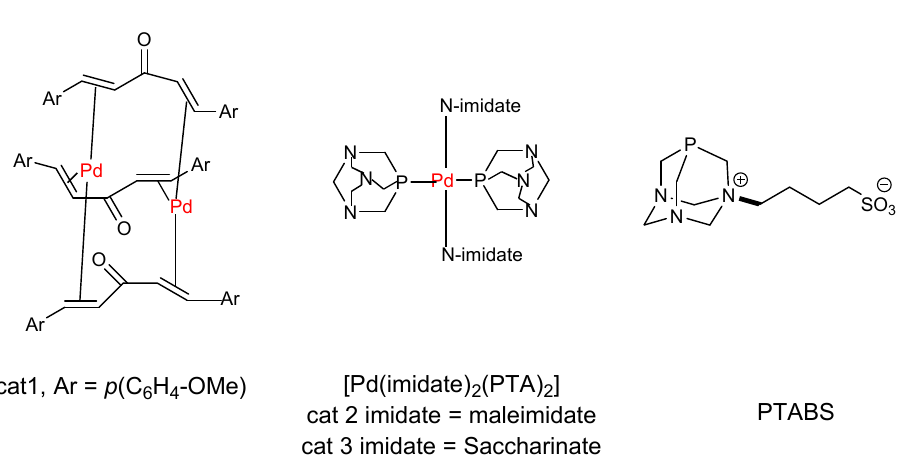
Figure 2. Systems for nucleoside modifications and cross-coupling.